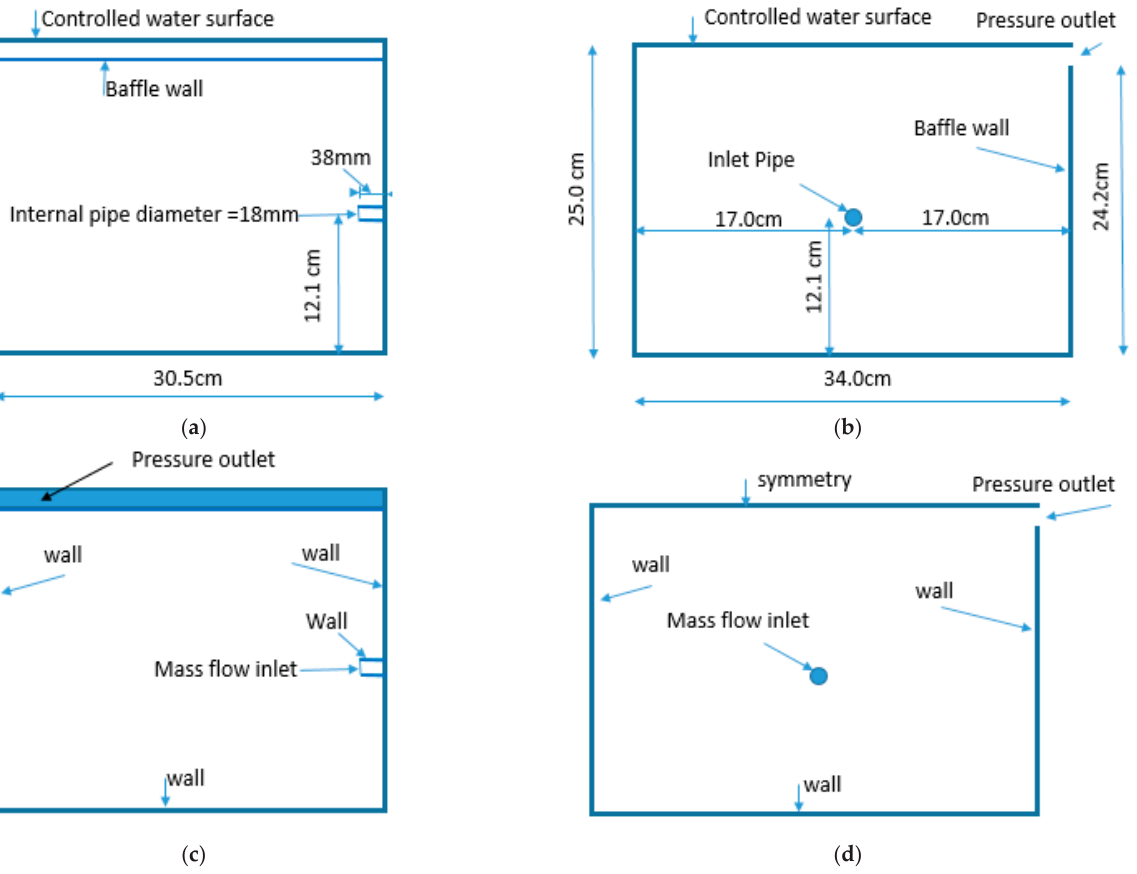
Figure 6. Schematic Figure of the CFD model: ( a ) Side view of the CFD model dimension, ( b ) Front view of the CFD model dimension, ( c ) Side view of the CFD model boundary, ( d ) Front view of the CFD model boundary.